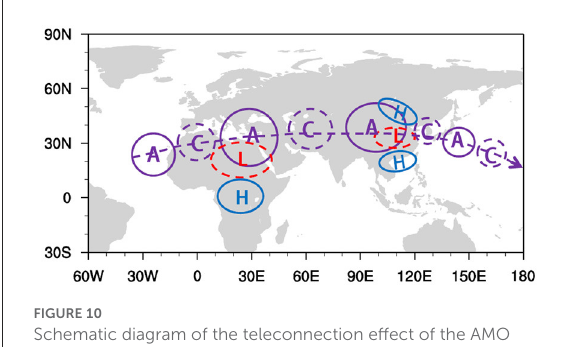
FIGURE10 Schematic diagram of the teleconnection effect of the AMO warm phase to the Asian summer monsoon precipitation (L and H indicate surface anomalous warm cyclone and subtropical anticyclone systems, respectively; A and C indicate anomalous anticyclones and cyclones in the upper troposphere, respectively; dotted line with arrow represents the teleconnection wave train during the AMO warm phase) (Li et al., 2017).